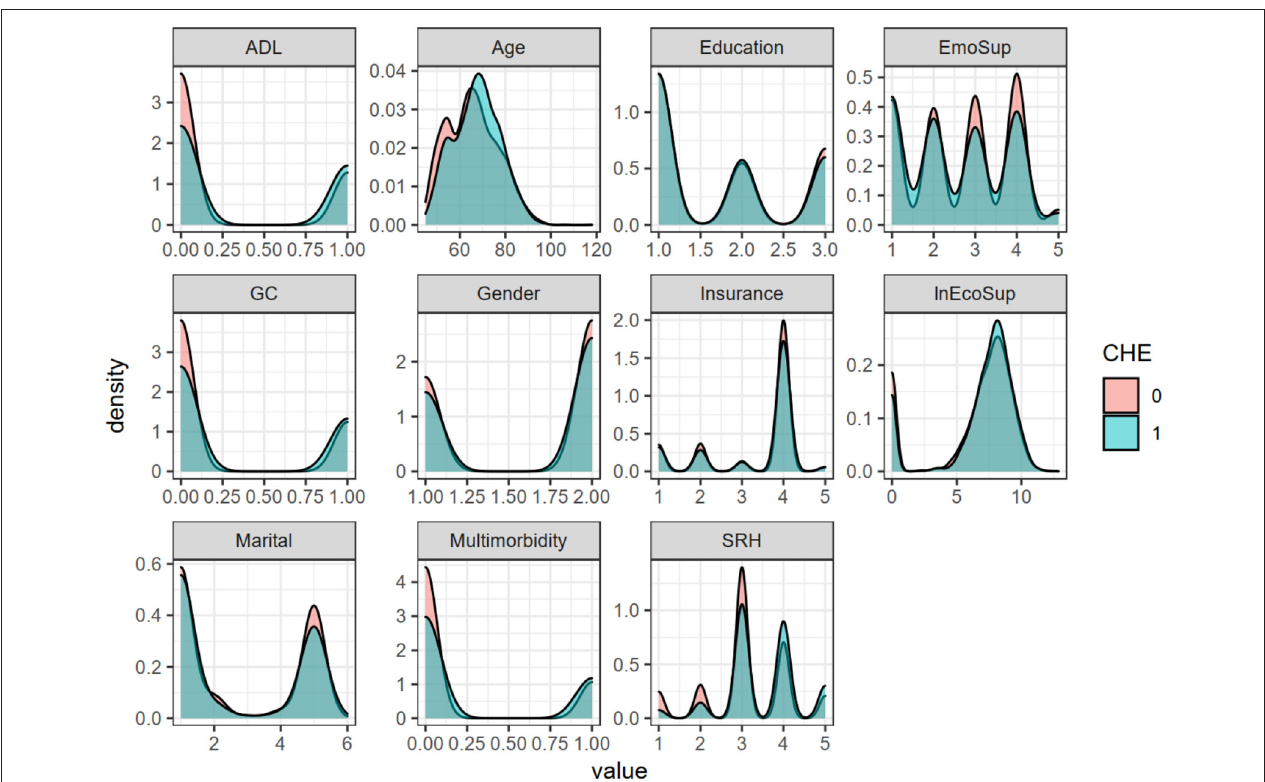
FIGURE 1 | Density curves of respective variables under different catastrophic health